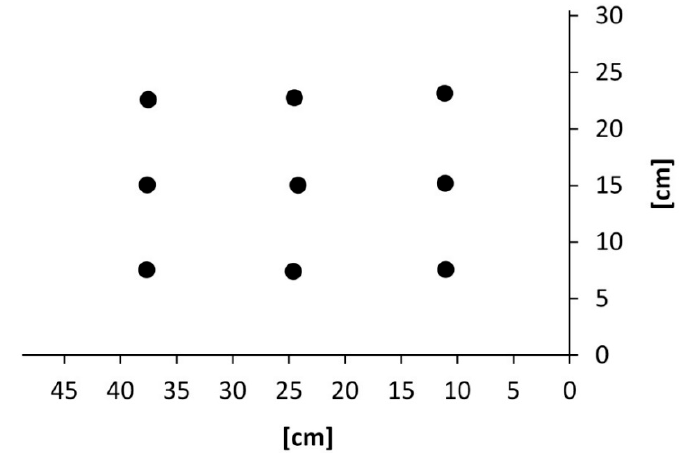
Figure 3. The originally invisible target point positions on the digitizing tablet. The lengths of the axes correspond to the dimension of the digitizing tablet.